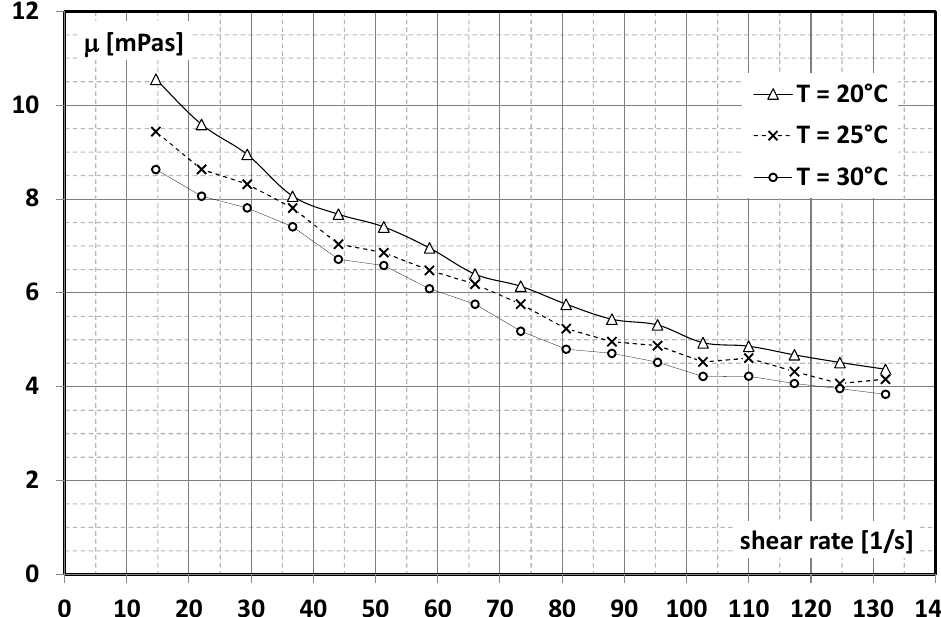
Figure 2. Dependence of slurry’s viscosity (21.5% MPCM) on the shear rate and temperature.